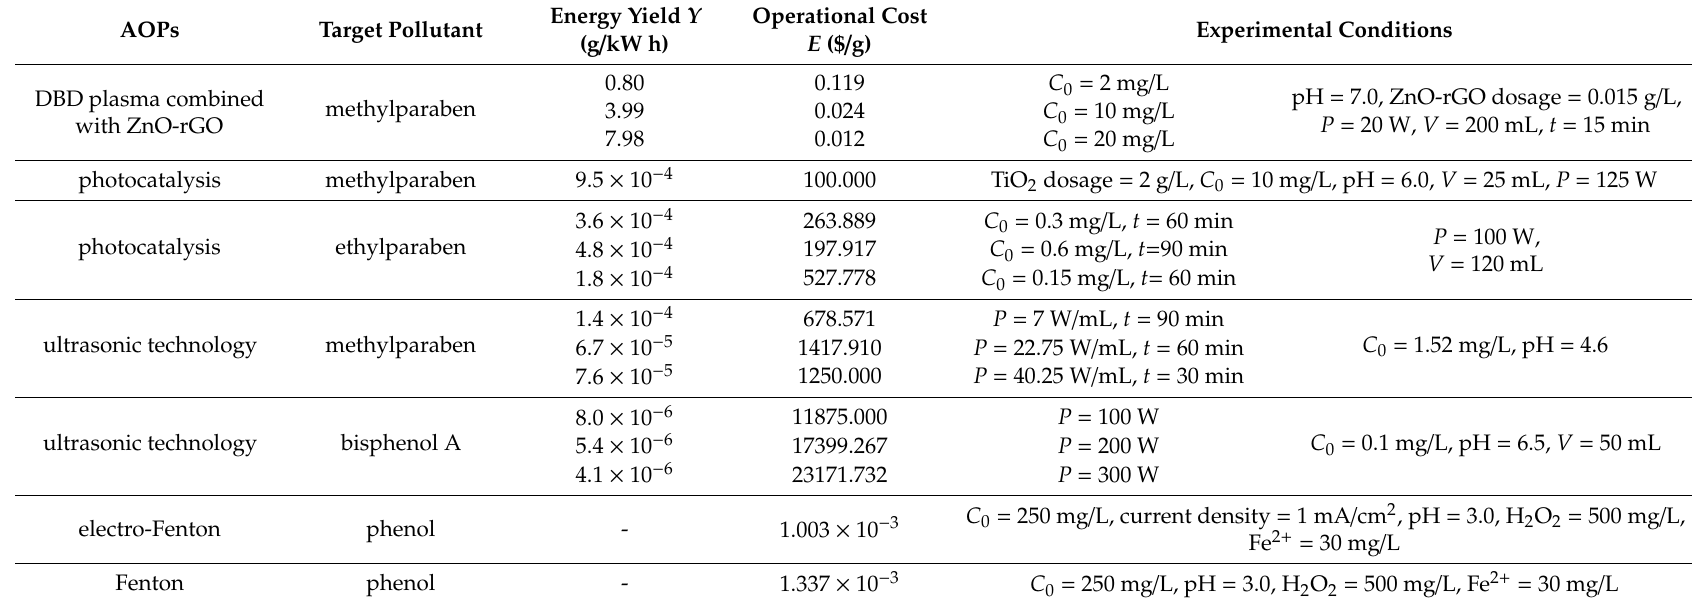
Table 4. Economic evaluation of the main AOPs for degradation of di ff erent organic pollutants in